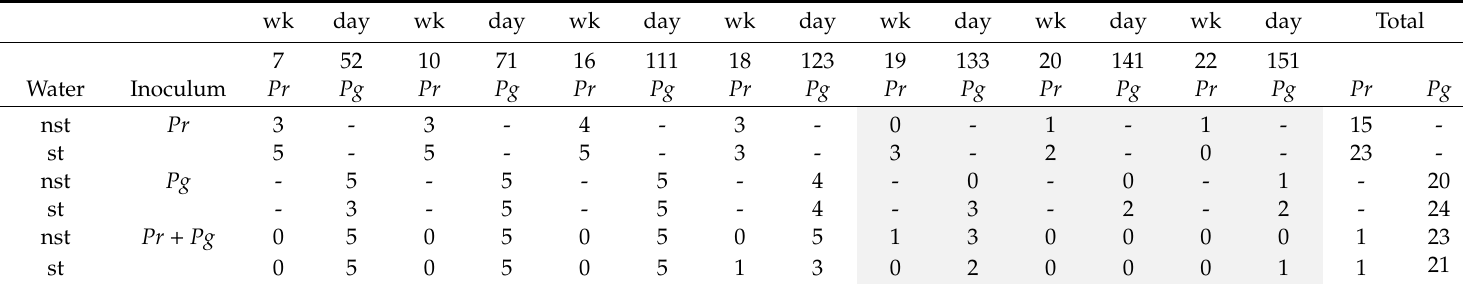
Table 1. Count of P. ramorum ( Pr ) and P. gonapodyides ( Pg ) recovery from single leaf disc baits deployed for three to seven days in a total of five microcosms per treatment (i.e., out of five possible colonization events per sampling, 35 total. Dash indicates not inoculated and not recovered) in the first experiment where green and brown leaves were maintained together in microcosms with either sterile (st) or non-sterile (nst) stream water added. Grey shading indicates results from after all leaves had been removed from the microcosms (126 days).